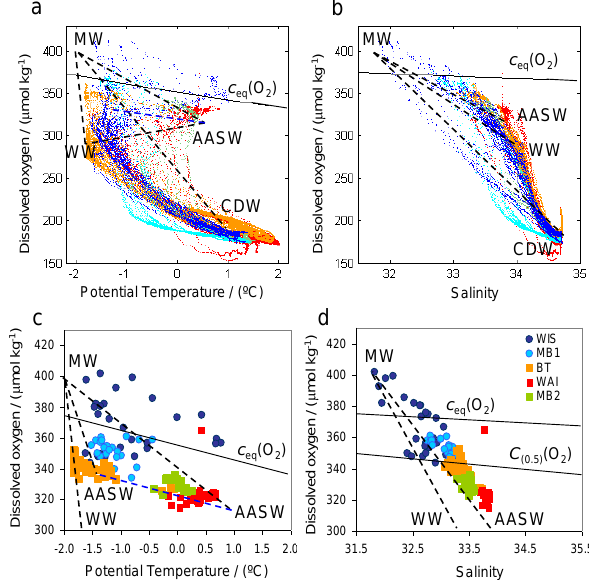
Fig. 4. Plots of dissolved oxygen against potential temperature and salinity. (a) and (b) include all measurements for identification of water masses; (c) and (d) only show mixed-layer data. Dashed lines correspond to the mixing lines given by the end points of properties for the different water masses. Solid lines show the O 2 concentra- tions at air saturation at (a, c) constant salinity of 33.5 and (b, d) constant temperature at seawater surface freezing point ( − 1.8 ◦ C). Note in panel (c) the blue dashed line represents the wide range of temperatures that characterize the AASW, extending from colder ( < − 1.0 ◦ C) to warmer ( > 0.5 ◦ C) waters. (d) WIS and MB1 are supersaturated in O 2 , considering the range of temperature domi- nated in the mixed layer of these areas ( − 1.8 <θ < 0.5 ◦ C). c (O 2 ) at these constant temperatures is depicted ( c eq (O 2 ) at − 1.8 ◦ C and c ( 0 . 5 ) (O 2 ) at 0.5 ◦